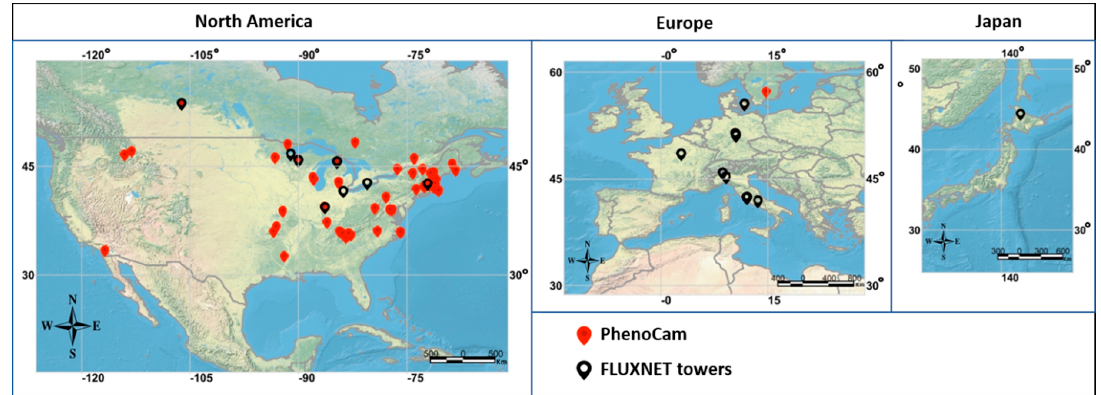
Figure 1. Locations of the selected PhenoCam sites (red) and FLUXNET towers (black) over deciduous forests.